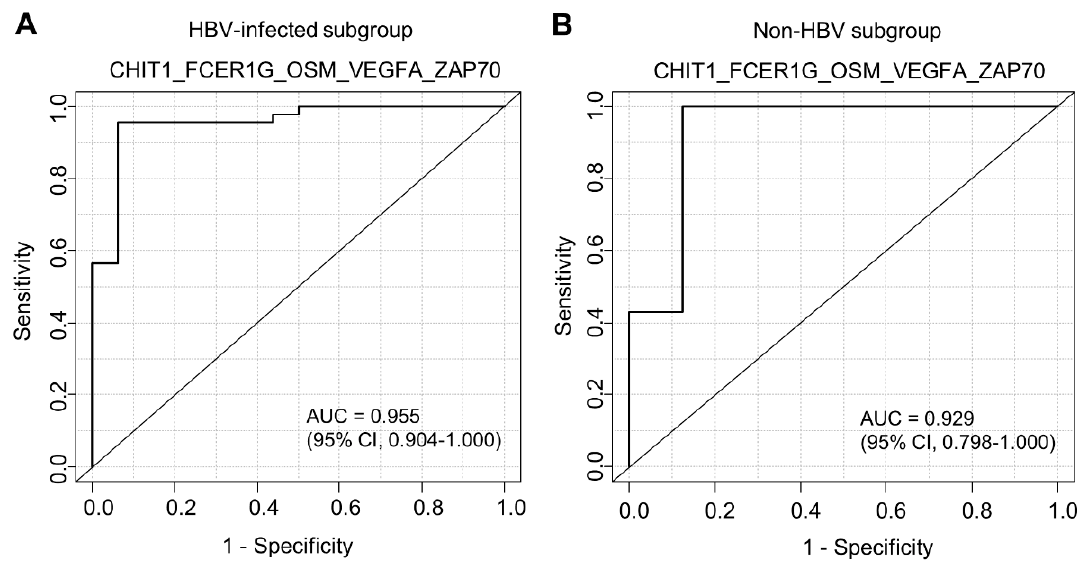
Figure 3. Expression of each gene comprising the gene signature in early stage versus late-stage liver fibrosis. Relative expressions of 5 genes in 24 patients with early-stage fibrosis and in 53 pa- tients with late-stage fibrosis. * p < 0.05; ** p < 0.01. ( A ) CHIT1. ( B ) FCER1G. ( C ) OSM. ( D ) VEGFA. ( E ) ZAP70.